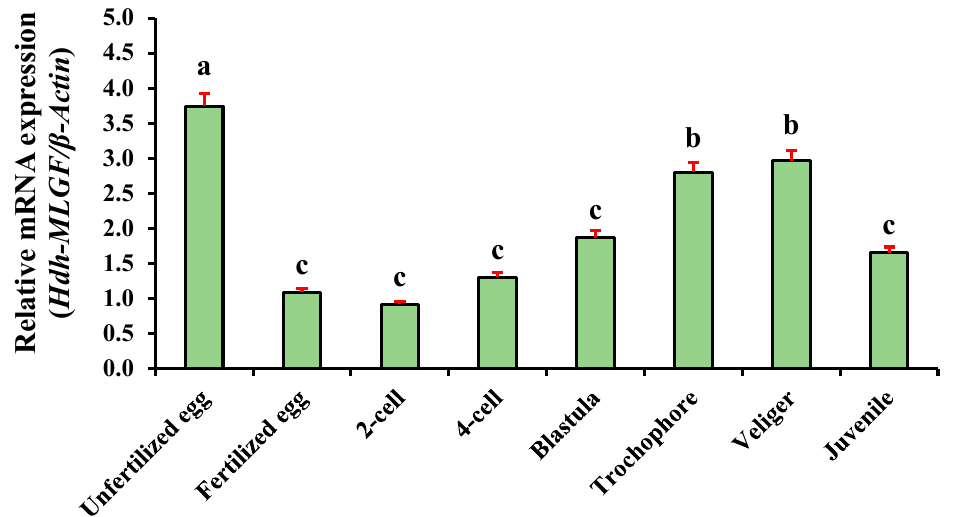
Figure 8. Expression of Hdh-TPM mRNA in embryonic and larval developmental stages of Pacific abalone. Significantly different levels ( p < 0.05) are denoted by different letters.